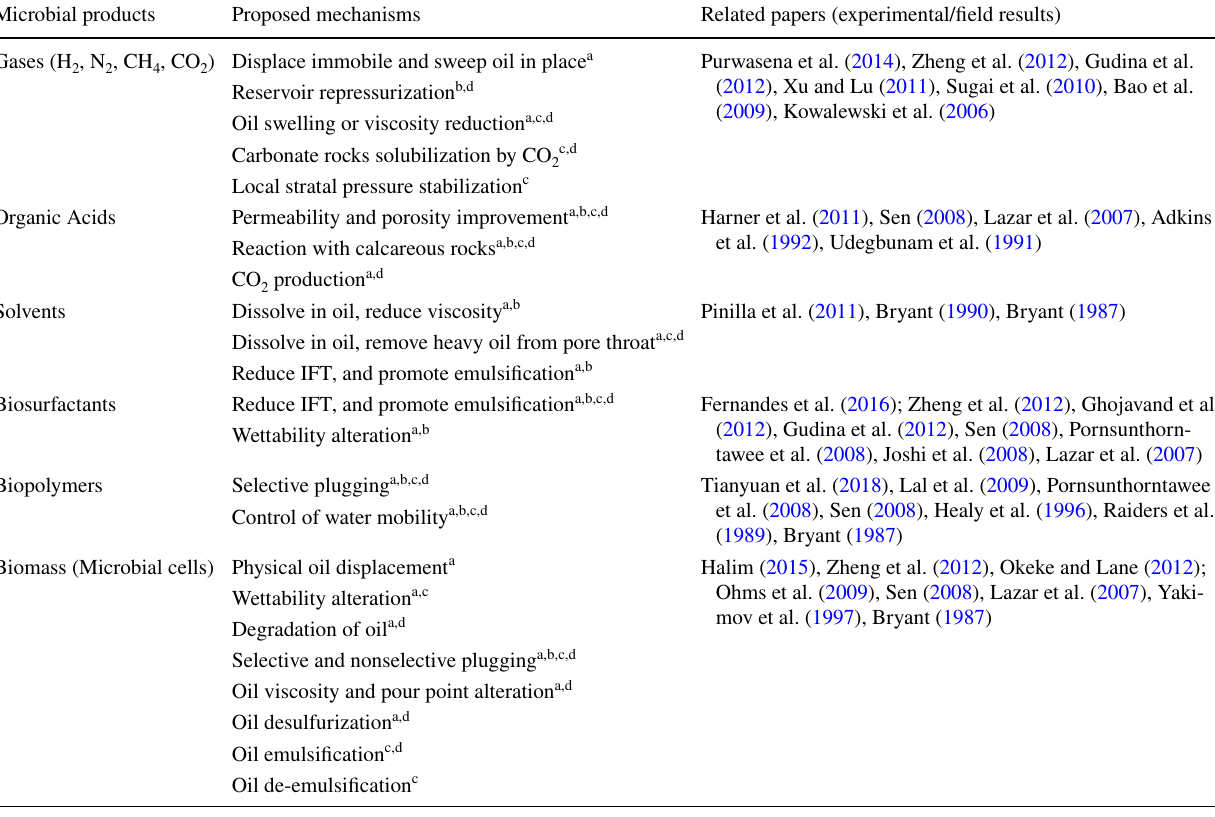
Table 1 Role of microbial bioproducts in